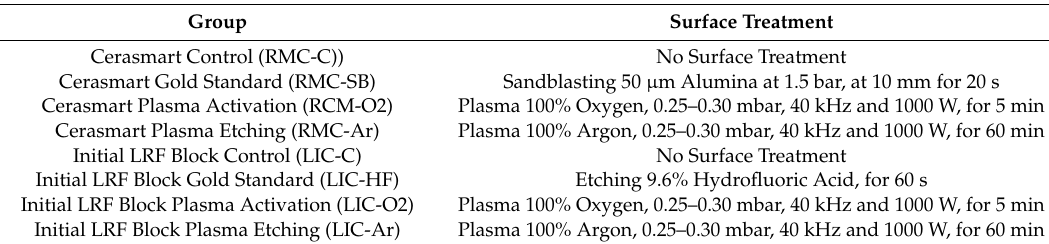
Table 2. Surface treatments groups.